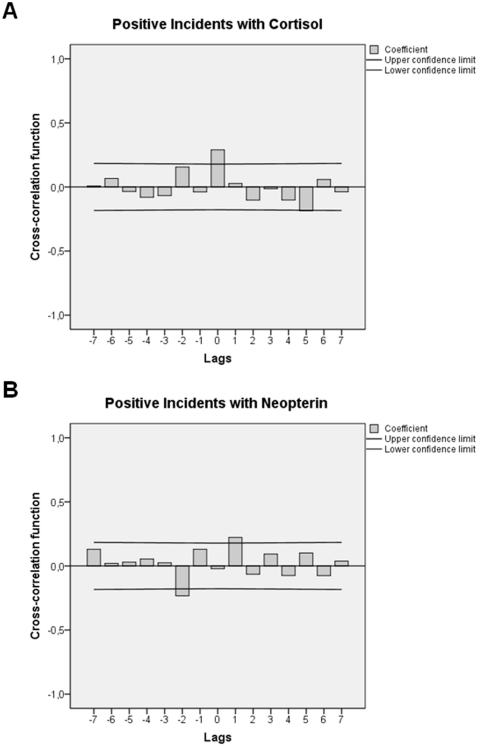
Adjusted cross-correlation functions indicating that positive incidents related to “educational and/or social accomplishment” are associated with cyclic responses in urinary cortisol and urinary neopterin levels.Each lag represents a time interval of 12 h. Coefficients (bars) reaching the upper or lower confidence limits (lines) are significant at p<.05. In A) positive incidents are followed by urinary cortisol concentration increases at ±lag 0 (0–12 h) and decreases at +lag 5 (60–72 h). In B) positive incidents are precipitated by urinary neopterin level decreases at −lag 2 (12–24 h) and followed by urinary neopterin level increases at +lag 1 (12–24 h).